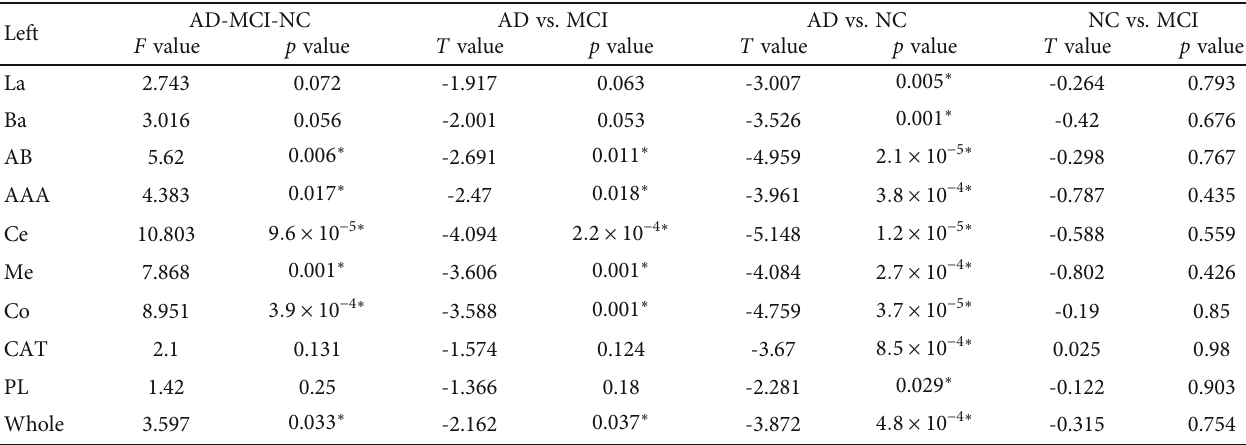
Table 6: ANOVA test and multiple comparison results of the subregion volumes of the left amygdala between the three groups.